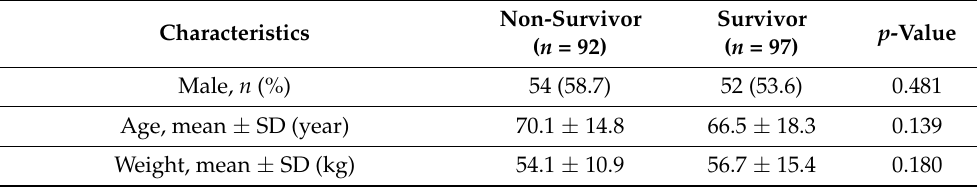
Table 1. Baseline Table 1. Baseline characteristics.